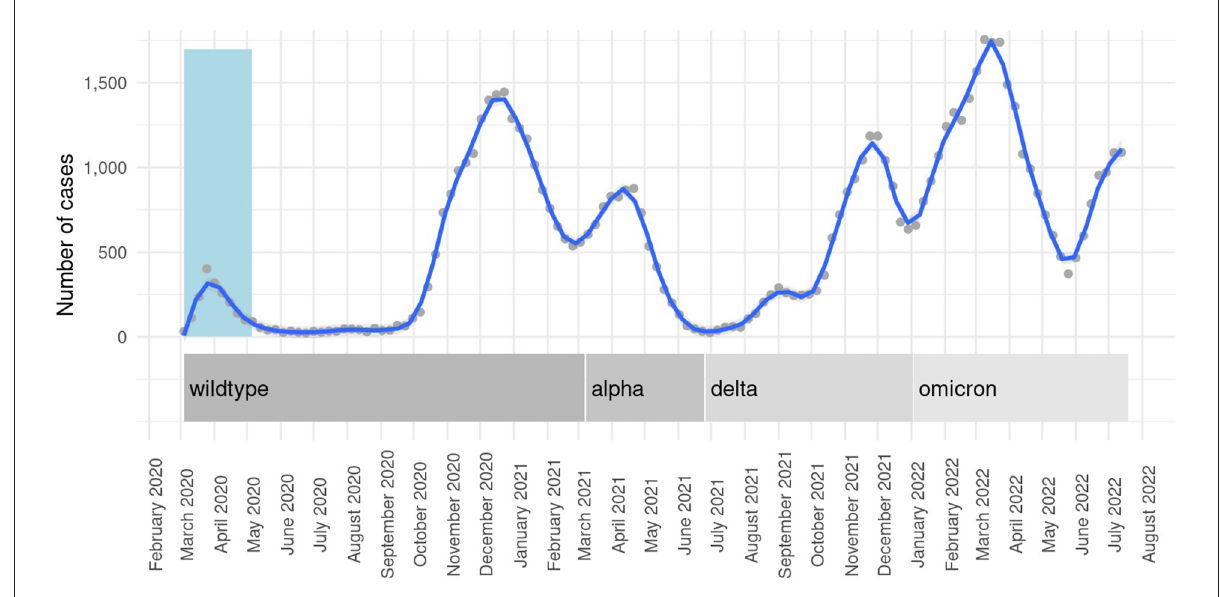
FIGURE1 Weekly SARS-CoV-2 admissions and corresponding variant predominance throughout the pandemic. Locally estimated scatterplot smoothing curves with 95% CIs for weekly case numbers as a function of admission week. Light-blue column represents the first pandemic wave.